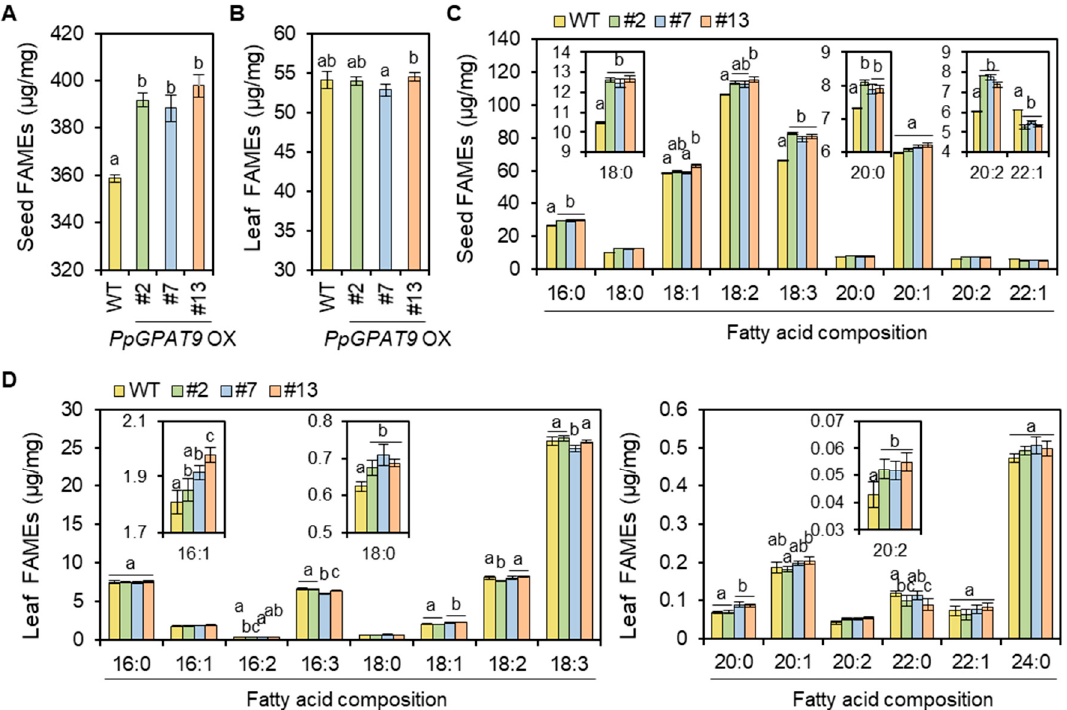
Figure 6. Fatty acid content and composition in the seeds ( A and C ) and leaves ( B and D ) of the WT and transgenic lines ectopically expressing PpGPAT9 (#2, #7, and #13). Hundred dry seeds and 4-week-old leaves were used to extract the fatty acids. FAMEs were determined using GC-FID. Error bars indicate mean ± SE of three independent measurements. The data were statistically examined using ANOVA with Tukey’s test at 95% confidence interval. The percentage values indicate the portion of increased fatty acids when compared with the wild type.